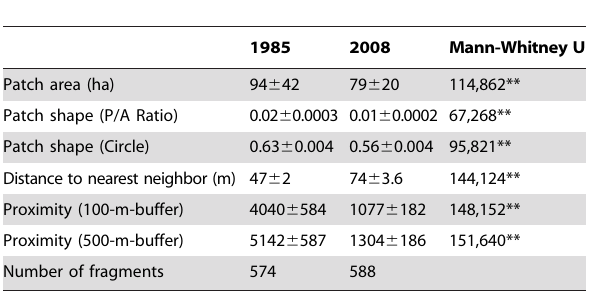
Table 3. Summary statistics (average 6 standard error) of the six variables used to quantify changes in patch features between 1985 and 2008.